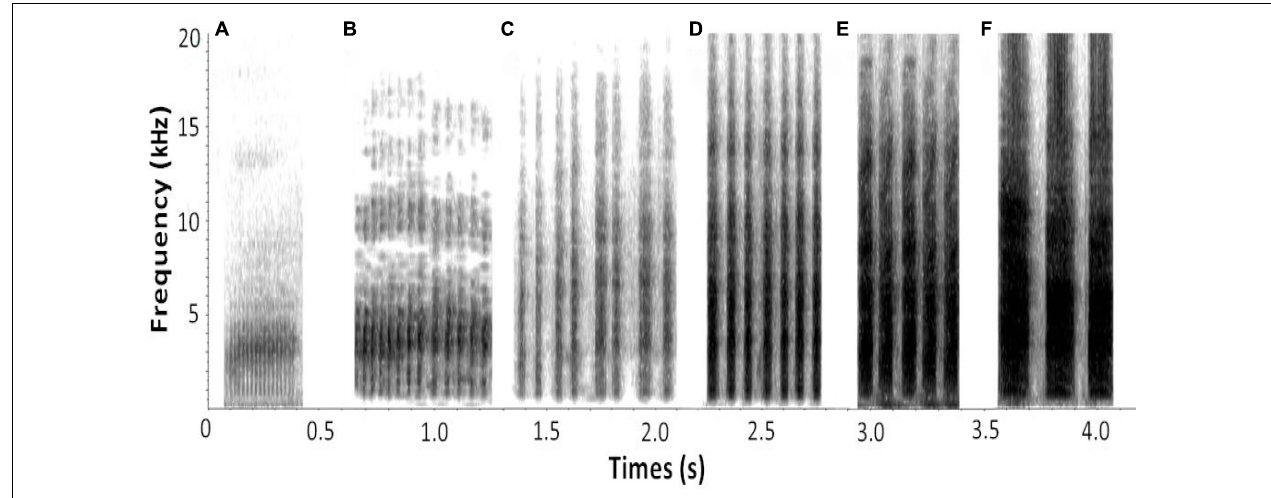
FIGURE 1 | Alarm calls spectrogram of six note types produced by A. orientalis (aggressive behavior is escalated from A to F, where F is related to the attack